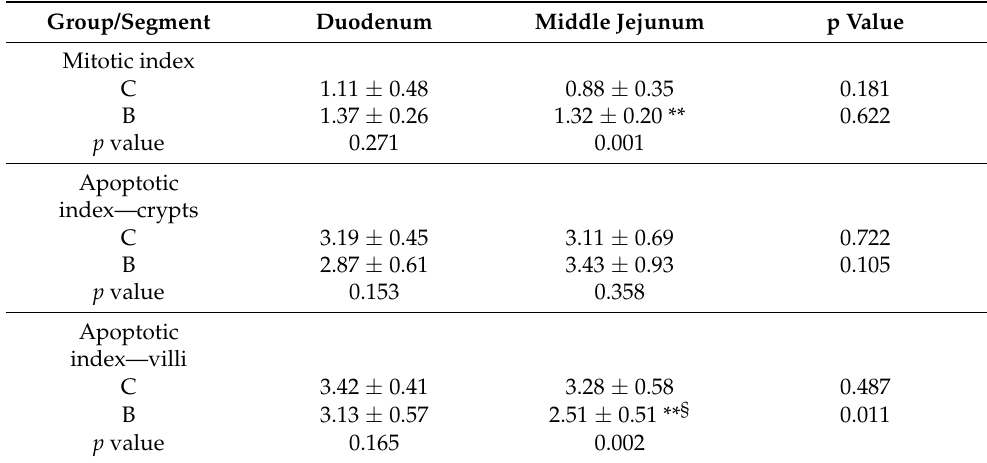
Table 3. The mitotic and apoptotic indices in control (C) and sodium-butyrate-treated piglets (B). Values are given as means ± SD; Indicates statistical differences between groups when ** p < 0.01; § indicates statistical differences between intestinal segments when § p < 0.05.